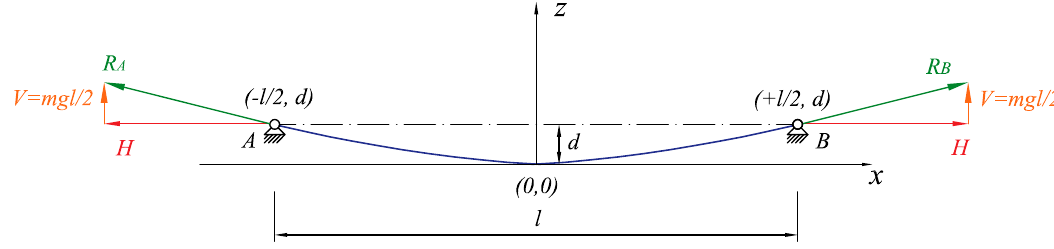
Figure 1. Cable profile for one static equilibrium state.